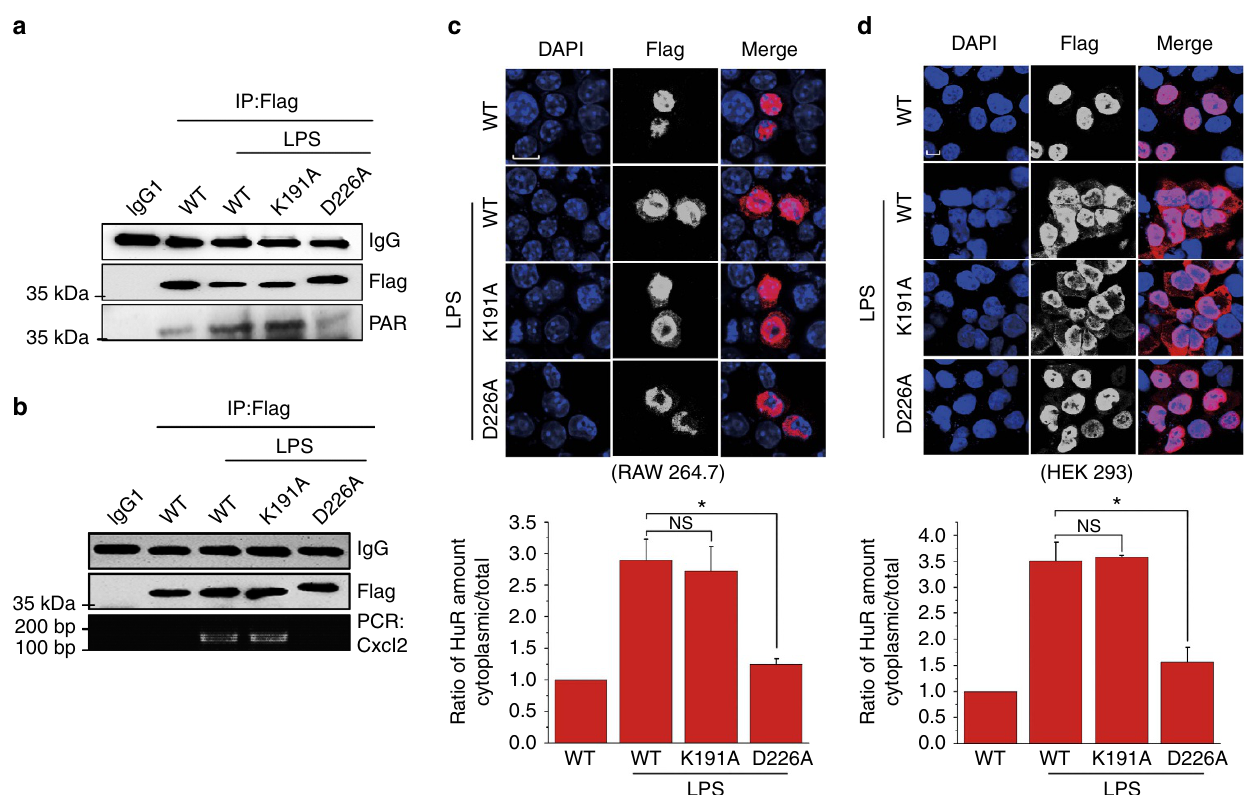
Figure 8 | The HuR D226 mutant cannot be effectively PARylated, bind with Cxcl2 mRNA, undergo nucleocytoplasmic shuttling. ( a ) The HuR D226 mutant showed no PARylation in LPS-exposed cells. HEK 293 cells were transfected with wild-type (WT) Flag-HuR, as well as K191A and D226A mutant plasmids, and then challenged with LPS, or not for 5h. Immuno-precipitates were prepared using a FLAG antibody and then subjected to immunoblotting to detect PARylation levels. ( b ) The HuR D226 mutant is defective in binding to Cxcl2 mRNA in response to LPS exposure. HEK 293 cells were transfected with WT Flag-HuR, as well as K191A and D226A mutant plasmids. RNA-IP was conducted using a FLAG antibody and the levels of precipitated Cxcl2 mRNA were detected by PCR with reverse transcription and electrophoresis as described in Methods. ( c , d ) The HuR D226 mutant failed to undergo nucleocytoplasmic shuttling in LPS-exposed cells. Experiments were undertaken as described above. Immune-fluorescence staining was conducted using a FLAG antibody to detect the location of WT HuR and the mutants in RAW 264.7 ( c ) and HEK 293 cells ( d ). Scale bar, 10 m m. The cytoplasmic distribution of HuR was quantified by densitometry analysis using Image J software (version 1.44; lower panels) as described in Methods. Scale bar, 10 m m. Data were expressed as mean ± s.d. ( n ¼ 5), and analysed by one-way analysis of variance. * P o 0.05, NS, not